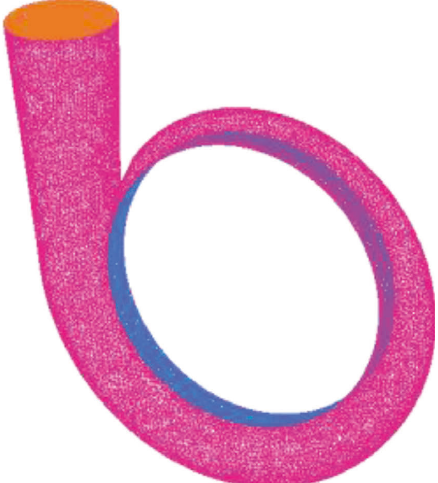
Figure 6: Hydraulic grid of the volute.